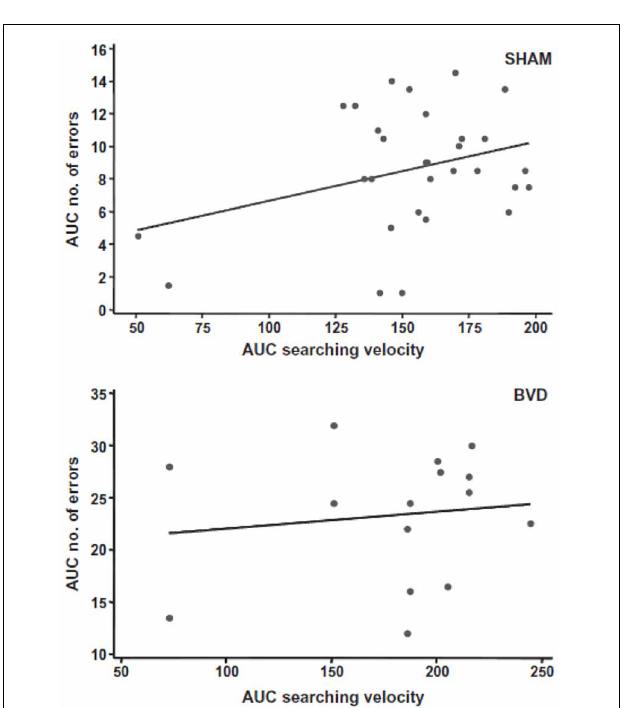
FIGURE 7 | A scatter graph showing a simple linear regression analysis to predict the number of errors made by all of the sham or BVD animals (in terms of the area under the curve) from their searching velocities in the foraging task, as an index of their locomotor hyperactivity. There was no significant prediction of spatial memory error from locomotor activity. Reproduced with permission from Baek et al.